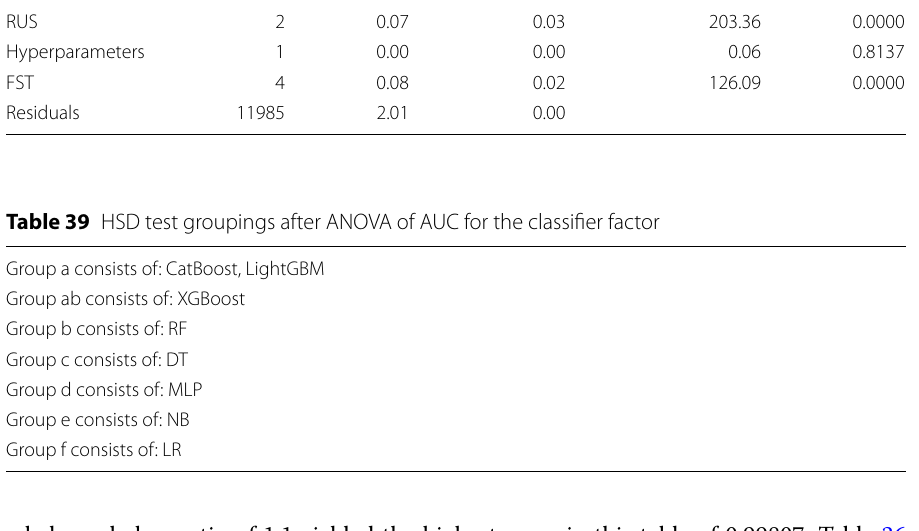
a balanced class ratio of 1:1 yielded the highest score in this table of 0.99807. Table 36 shows AUPRC scores obtained. CatBoost with a 6 Agree FST and no RUS produced the highest score in this table of 0.99988.